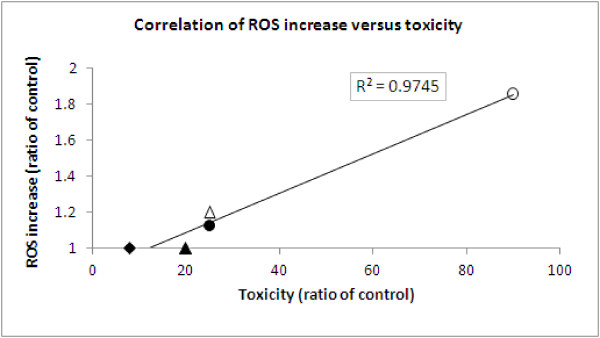
Correlation between toxicity and ROS level following incubation with Co-Fe NPs. Correlation between the toxicity (percent of dead cells) after 72 h incubation with 0.5 mM Co-Fe NPs (X axle) versus ROS increase after 1.5 h incubation with 0.5 mM Co-Fe NPs (Y axle); the correlation was fitted linearly yielding y = 0.011X + 0.87; all the results represent the ratio of control cells; the following symbols represent the different cell-lines: open circle – TK6 cells, filled circle – Caco2 cells, open triangle – MDCK cells, filled triangle – A549 cells, filled rhombus – HepG2 cells.